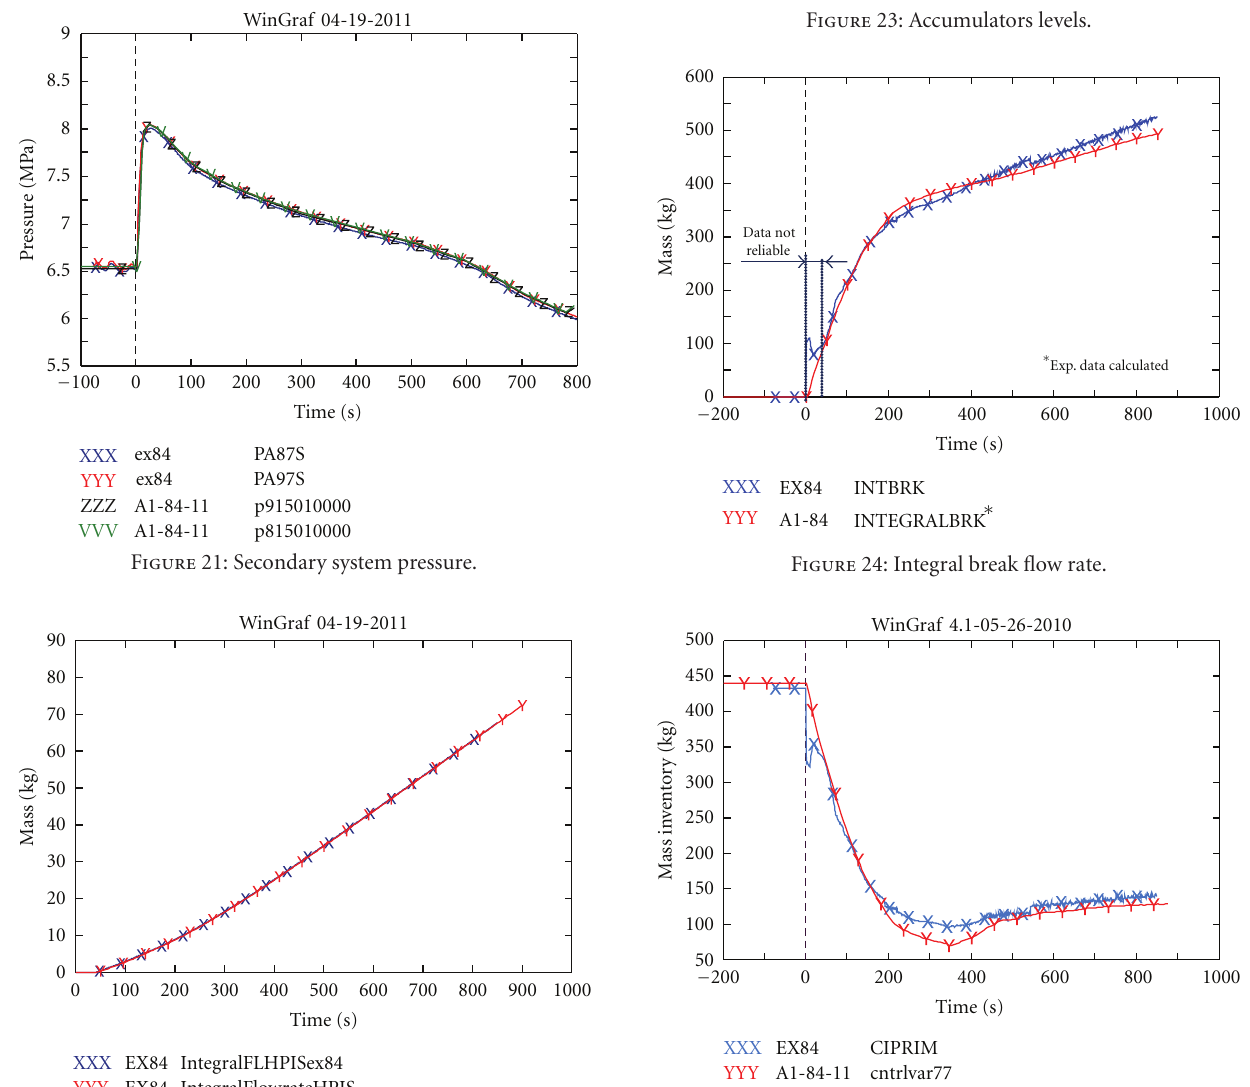
Figure 22: HPIS integral mass flow.